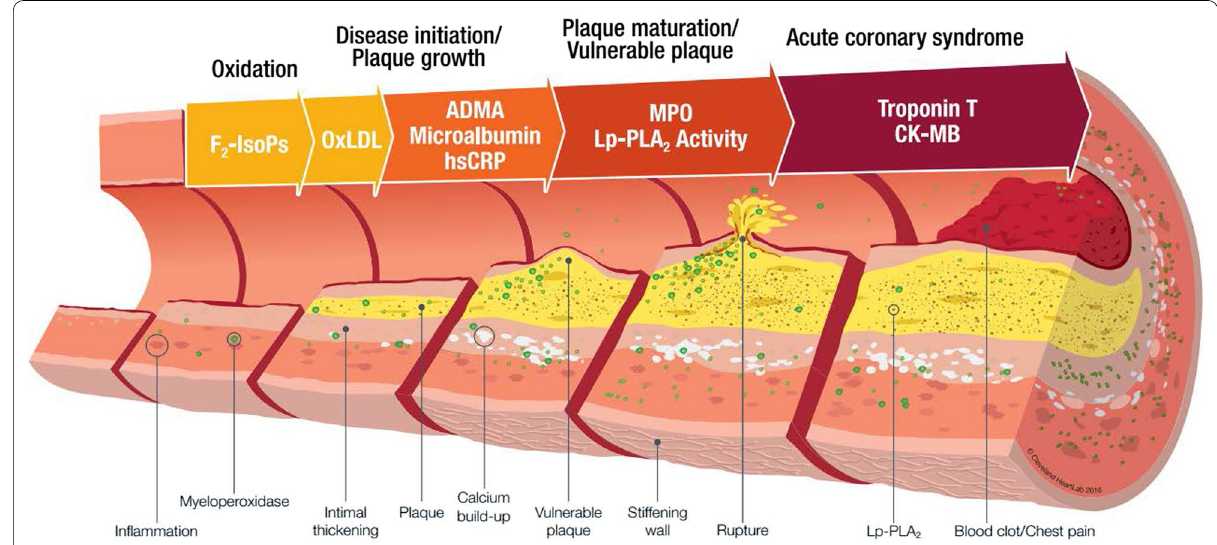
Fig. 5 Inflammatory Biomarkers and their Association with Atherosclerosis. Atherosclerosis is associated with specific inflammatory biomarkers, which can be measured to help evaluate a patient’s risk for heart disease and cardiac